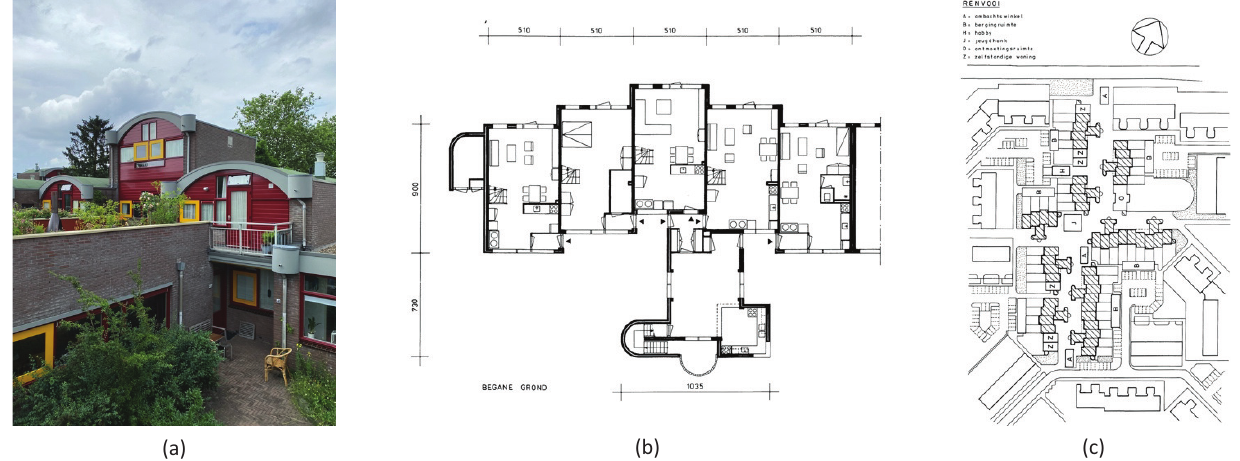
Figure 6. (a) Centraal Wonen Wandelmeent, Hilversum. (b) Plan of individual units sharing a cluster room. (c) Urban setting in neighborhood. Source: (a) Courtesy of Van Eig,